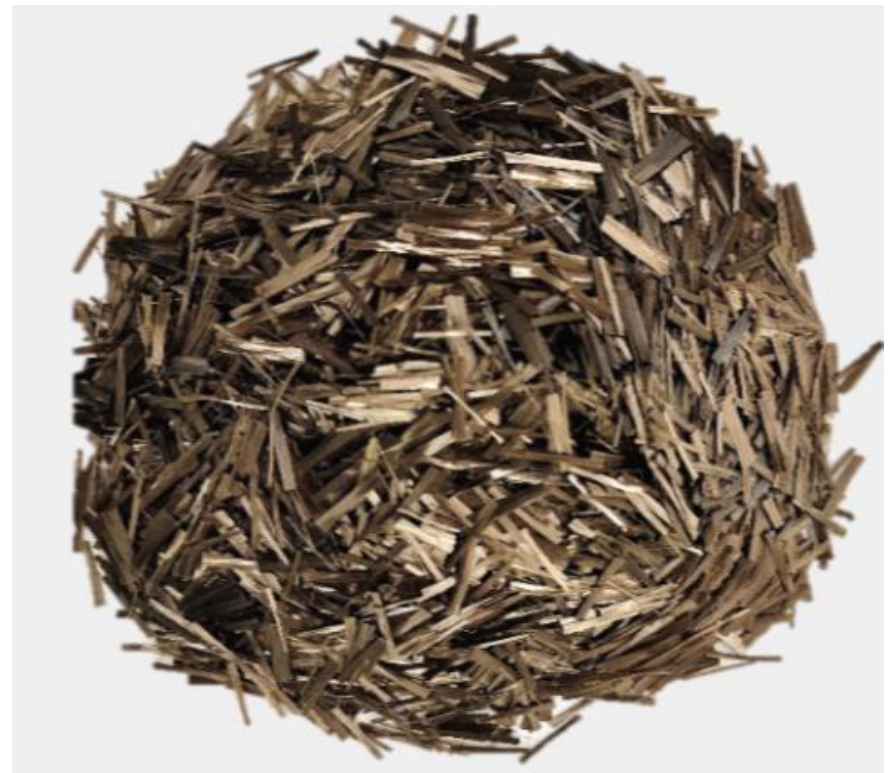
Figure 4. Chopped Basalt Fibers.